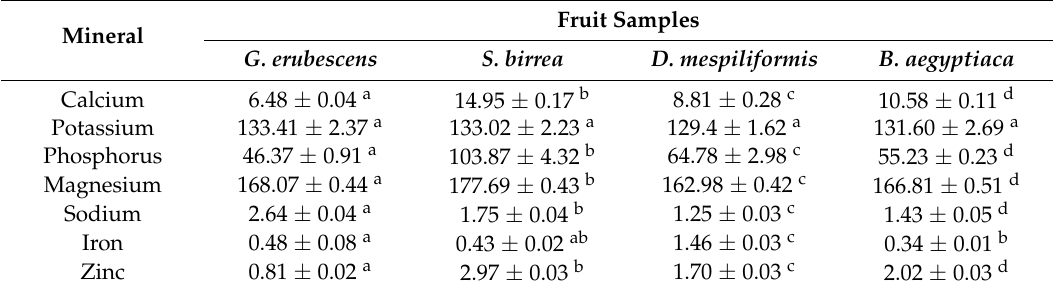
Table 3. Mineral composition (mg/100 g dry weight, or dw) of four edible underutilized forest